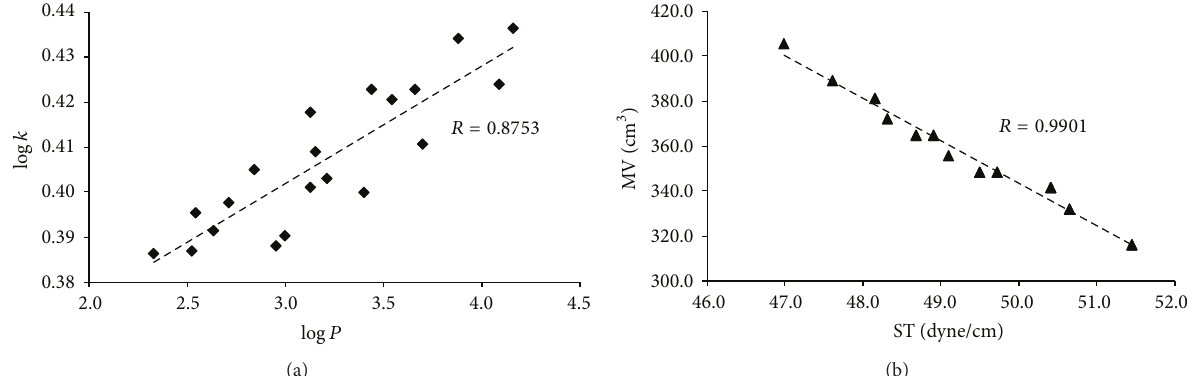
Figure 1: Comparison/match of experimentally found log 𝑘 values with calculated log 𝑃 of uncharged molecules (a); match of calculated data for uncharged molecules of molar volume with surface tension